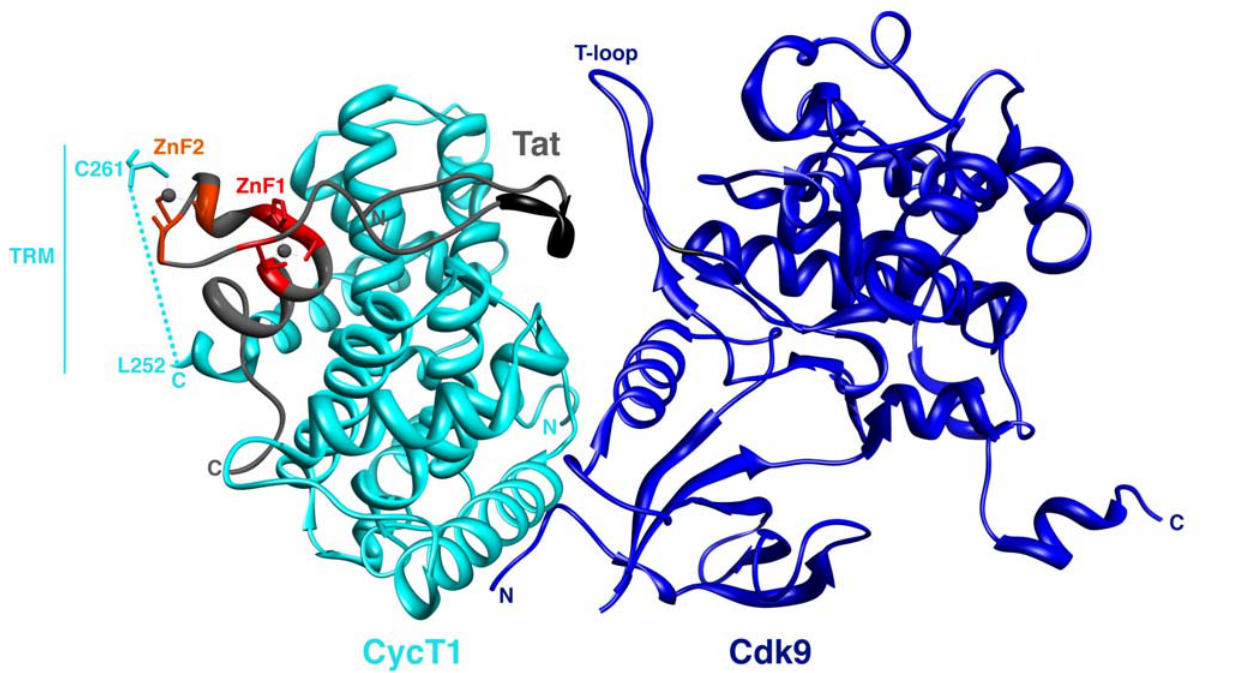
Figure 2. Structure of the Tat:P-TEFb complex. The Tat AD (gray) is observed to interact primarily with CycT1 (cyan) but also with the Cdk9 subunit (blue). The dashed line represents the distance between the last residue in CycT1 that is ordered in the structure (L252) and C261 (PDB 3MI9). TRM denotes the Tat-TAR Recognition Motif in